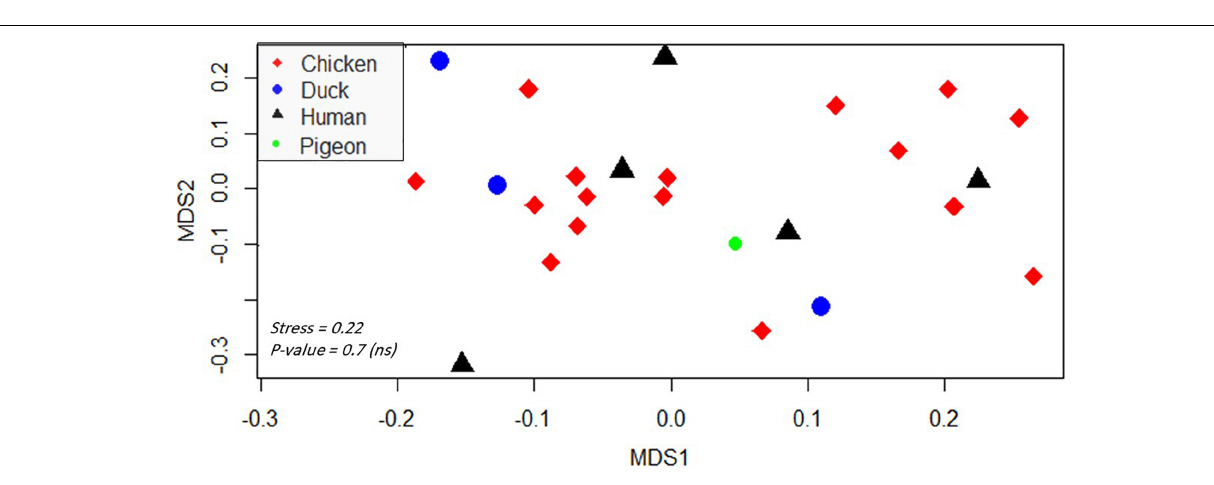
FIGURE 4 | Non-metric multidimensional scaling showing the clustering and overlap of various isolates belonging to different hosts. Different hosts are color- and shape-coded. Stress refers to the performance of the multidimensional scaling. The p -value was calculated by PERMANOVA test and refers to the significant clustering of the groups. A p -value < 0.05 indicates that isolates were not significantly clustered based on their hosts (thus there is an overlap among hosts). The abbreviations of codes are described in Table 2 in